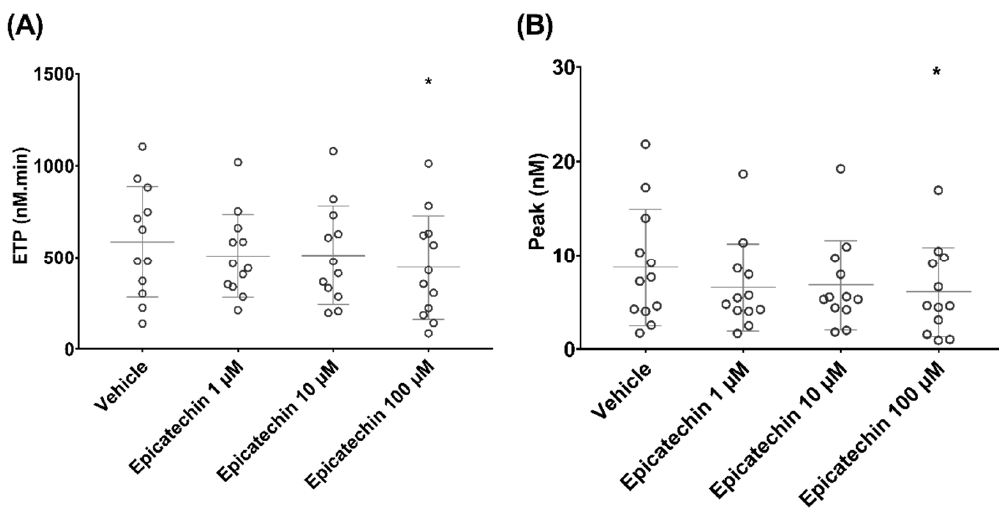
Figure 4. Effect of epicatechin on thrombin generation in microparticle-rich plasma. ( A ) Endogenous thrombin potential (ETP). ( B ) Thrombin peak. * Significant effect of intensity. In calcium-stimulated PRP, ETP decreased from 779 ± 246 in samples incubated with vehicle to 739 ± 243 ( p < 0.05), 774 ± 257 ( p = 0.4) and 708 ± 268 ( p < 0.001) in samples incubated with 1, 10 and 100 μ M epicatechin, respectively (Figure 5A). Thrombin peak also decreased from 65 ± 34 in samples incubated with vehicle to 60 ± 33 ( p < 0.05), 68 ± 33 ( p = 0.6) and 64 ± 41 ( p < 0.05) in samples incubated with 1, 10 and 100 μ M epicatechin, respectively (Figure 5B). Thrombin activation kinetics were similar in all experimental conditions, with a lag time of about 15 min and a time to peak of about 22 min.